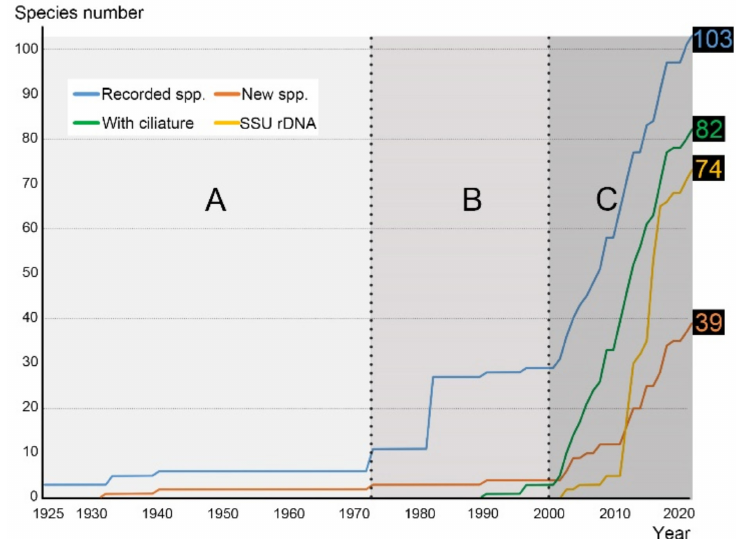
Figure 2. Timeline and accumulated numbers of studied cyrtophorian ciliates (species) in China. The four lines represent the numbers of recorded species, new species, species with ciliature information, and taxonomic hits (lowest taxonomic rank to species or genus) with SSU rDNA sequences. A, B, and C represent three study periods: the early stage ( A ) 1925–1973, the Tibet stage ( B ) 1974–2000, and the molecular stage ( C ) since the